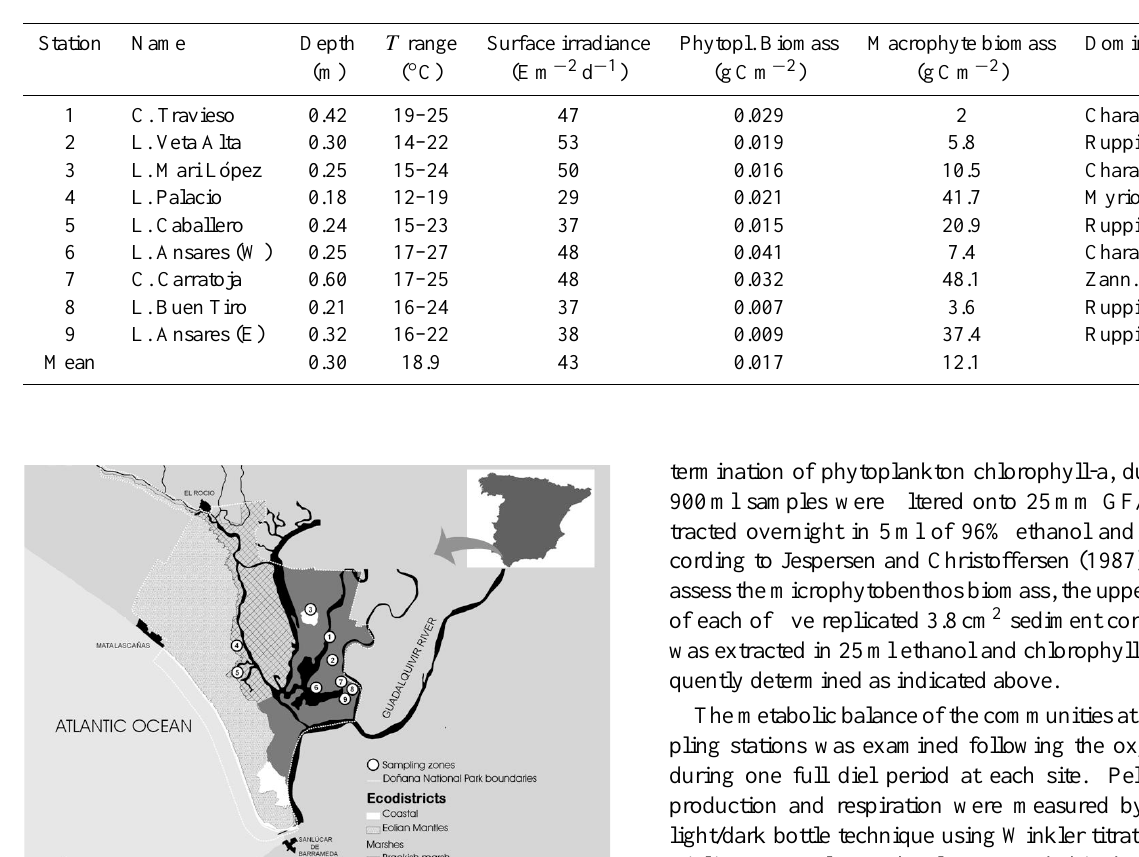
Table 1. Water depth, phytoplankton and macrophyte biomass, temperature range and daily irradiance (PAR) during the diel O 2 experiments in nine shallow Do˜nana lagoons. Dominant species are macrophyte species comprising more than 20% of the biomass. Chara= Chara sp-,